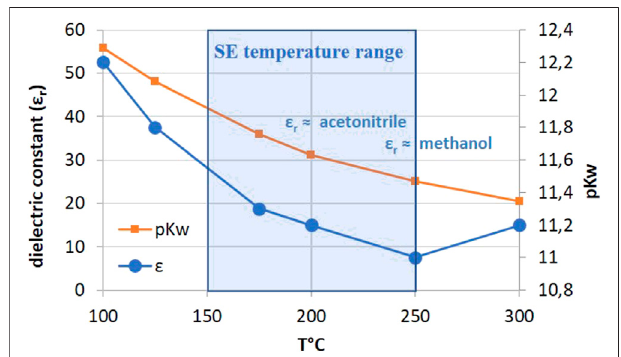
FIGURE 1 | Evolution of the relative dielectric constant of water with the